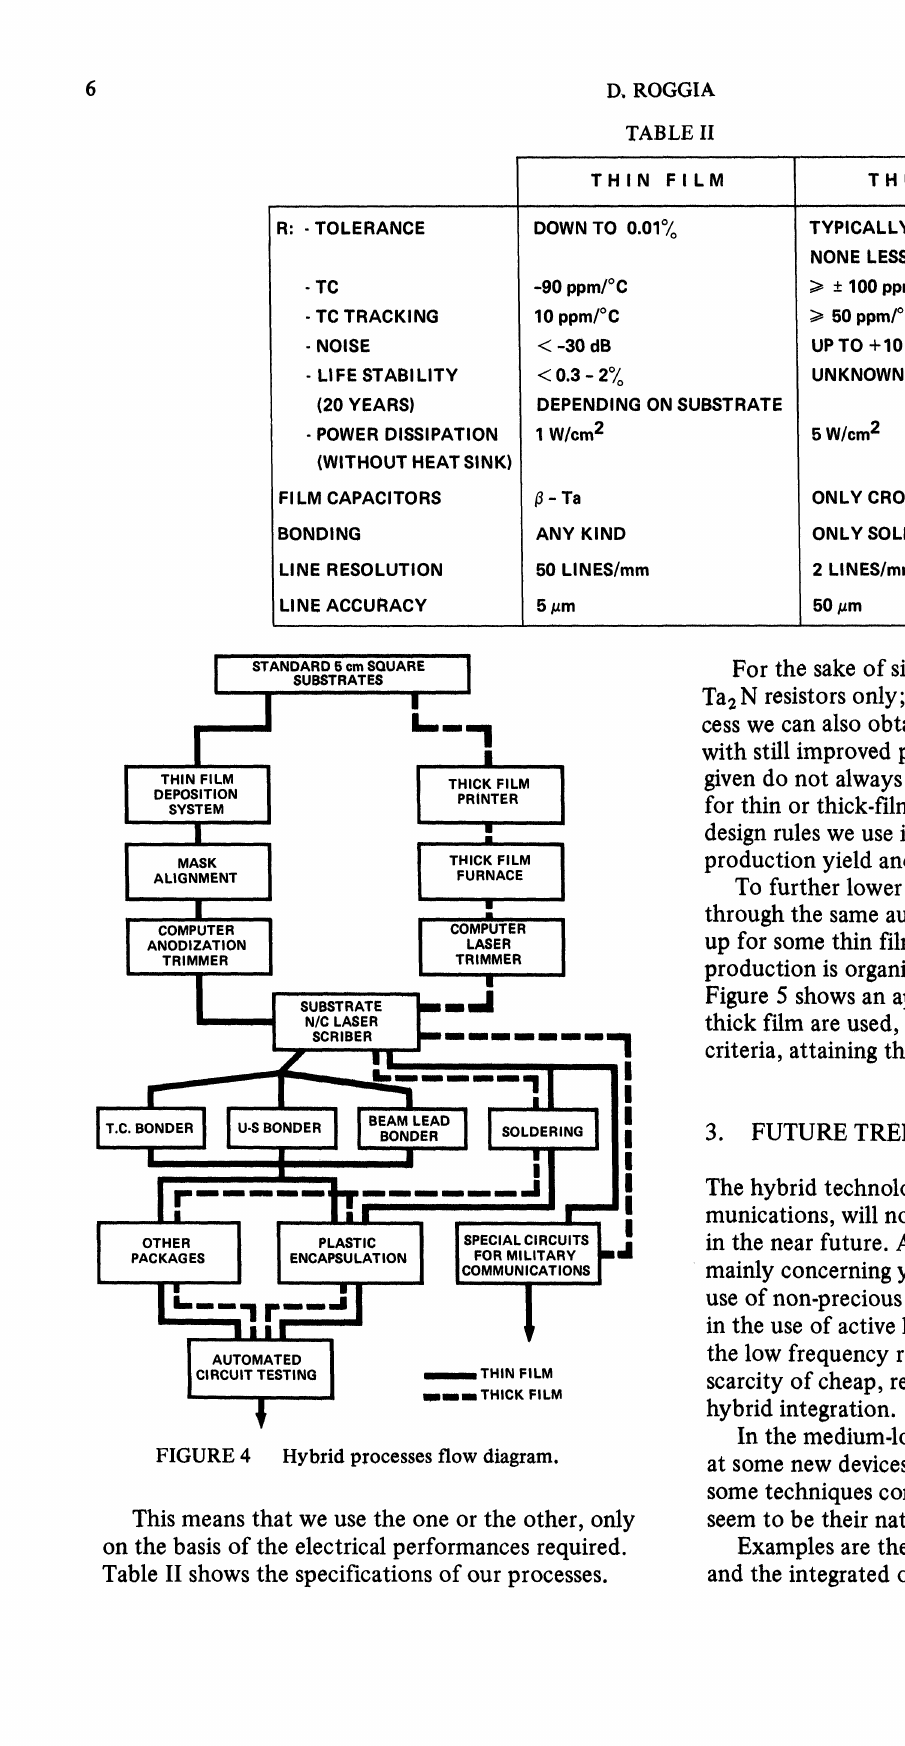
Hybrid processes flow